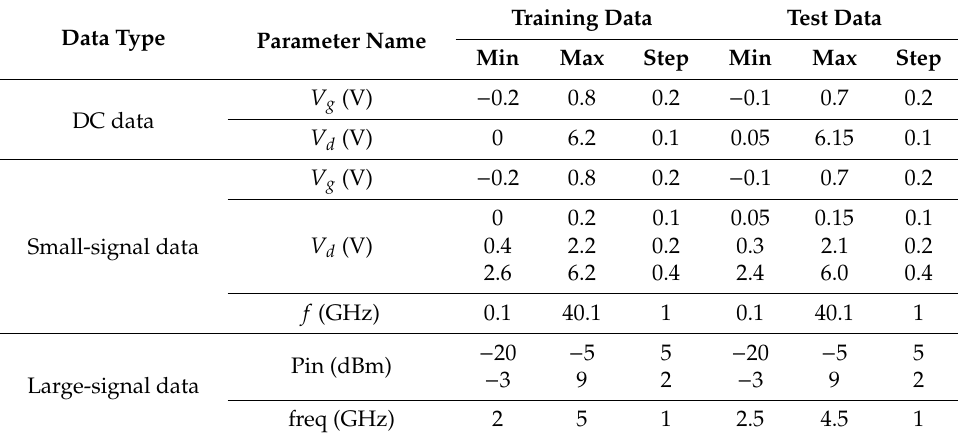
Table 5. Training data and test data for GaAs HEMT.